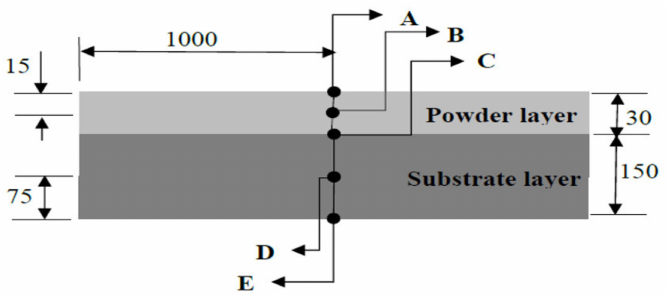
Figure 5. Location of points where temperatures were measured (all dimensions are in µ